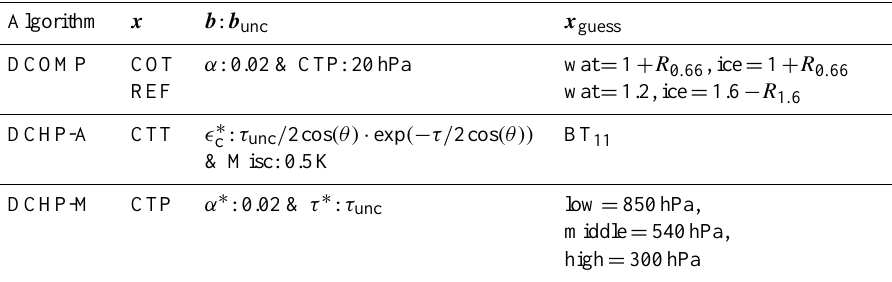
Table 3. Listed are the forward model parameters b and their uncertainties b unc as well as the first guess x guess used in the Daytime Cloud Optical and Microphysical Cloud Properties (DCOMP) retrieval and both the Daytime Cloud top Height Properties for AATSR (DCHP-A) and MERIS measurements (DCHP-M). The cloud optical thickness (COT, τ ) uncertainty, τ unc , is taken from the DCOMP results. Misc stands for miscellaneous and is an estimated forward model parameter uncertainty arising from differences in spectral response function of ATSR-2 (assumed in clear-sky RTTOV simulations) and AATSR, as well as tabular integration. In the cloud top pressure (CTP) retrieval, different first guesses are used for low ( > 680hPa), middle ( > 400 and < 680hPa) and high ( < 400hPa) clouds. To estimate the cloud height level, the previously retrieved cloud top temperature is converted to cloud top pressure using the ERA-Interim temperature profile. Here, α is surface albedo; (cid:15) c is cloud emissivity; wat and ice are the water and ice cloud phases, respectively; R 0 . 66 and R 1 . 6 are the reflectances in the AATSR 0.66 and 1.6µm channels, respectively; and BT 11 is the brightness temperature in the AATSR 11µm channel. Note that x guess is in log 10 space in DCOMP. ∗ Only performed for pixels with τ <